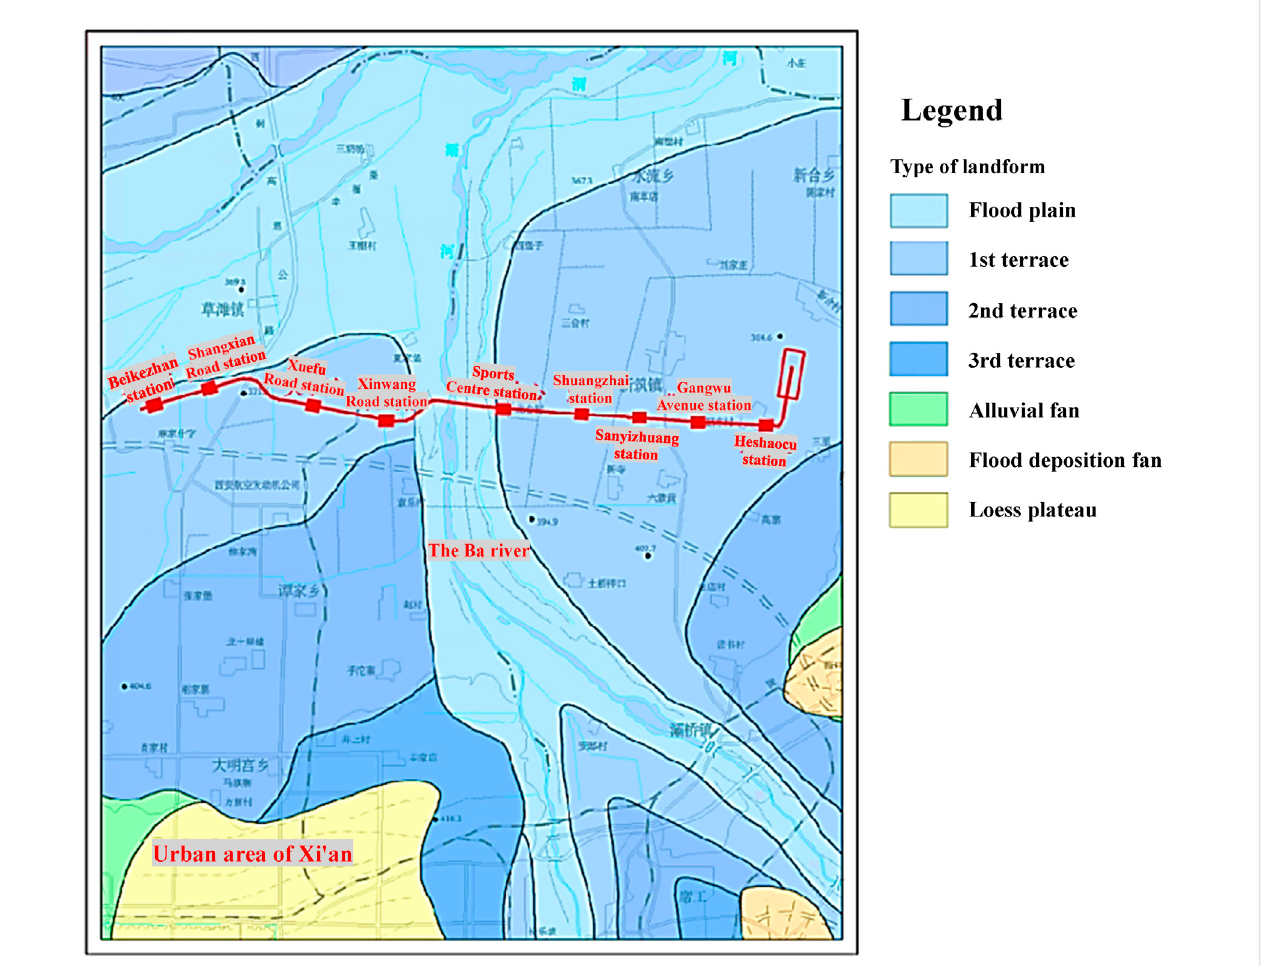
FIGURE 1 Topography along metro Line 14 of Xi ’